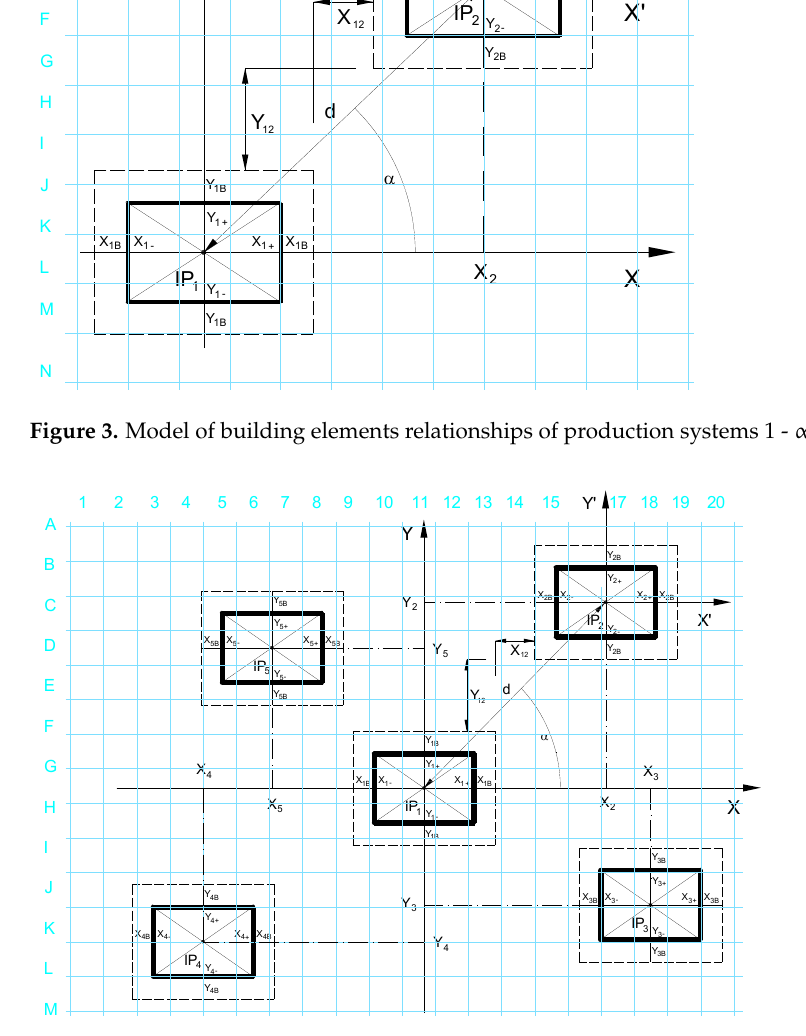
Figure 4. Relationship model for pilot structures of production systems [28].